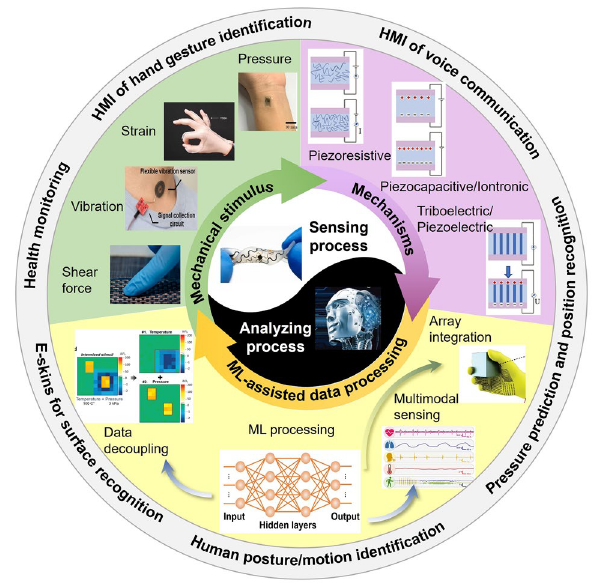
Fig. 1 An overview of stimuli, mechanisms, and ML-assisted data processing of flexible mechanical sensing technology. Mechanical stimuli: pressure [15] (Copyright (2019) The Authors), strain [23] (Copyright (2020) Springer Nature), vibration [31] (Copyright (2022) The Authors), and shear force [32] (Copyright (2020) American Chemical Society). Mechanisms: piezoresistive, piezocapacitive/ion- tronic, and triboelectric/piezoelectric [33] (Copyright (2021) Wiley– VCH). ML-assisted data processing: array integration [34] (Copy- right (2019) Springer Nature), multimodal sensing [35] (Copyright (2020) The Authors), and data decoupling [36] (Copyright (2020) Wiley–VCH). Sensing process [37] (Copyright (2022) Elsevier) and analyzing process [20] (Copyright (2021)